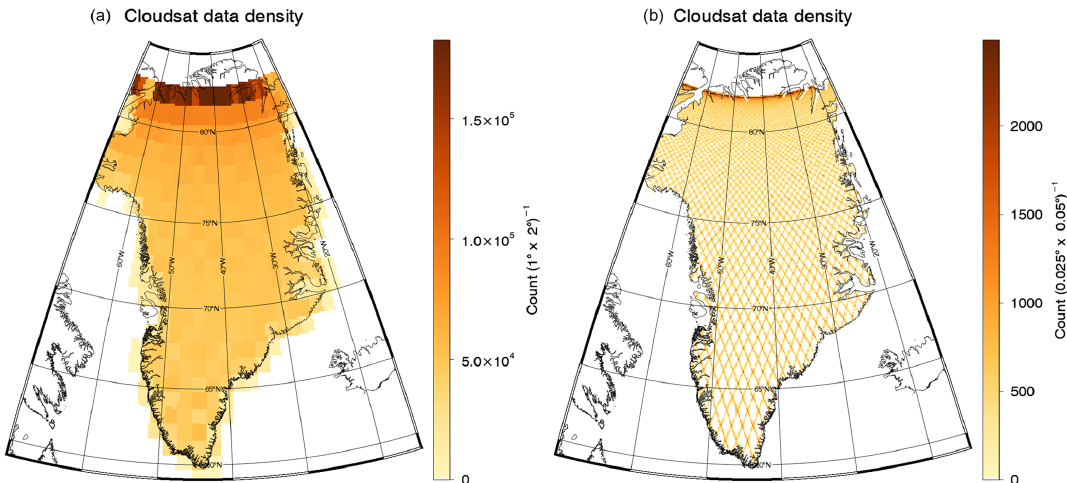
Figure 2. CloudSat data density over Greenland at 1 ◦ × 2 ◦ ( a , corresponding to 100km × 100km at 60 ◦ N) and 0.025 ◦ × 0.05 ◦ ( b , corre- sponding to 2.5km × 2.5km at 60 ◦ N). Shown is the total number of observations per grid box over the time period from 2006 to